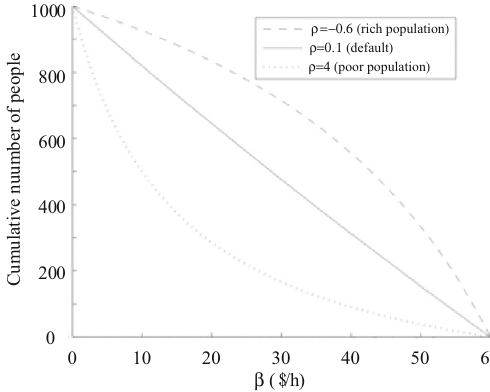
Fig. 6 VOT distribution used in the numerical studies [1]